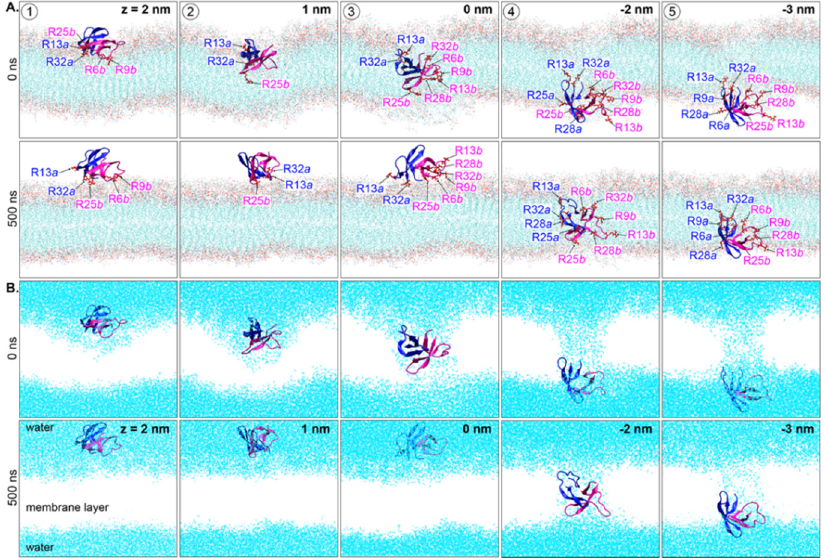
Figure 2. ( A ) Starting and final orientations of dimeric HD5 in a membrane at five positions. Water molecules in each system are shown in cyan in ( B ). Chains a and b of HD5 dimer are displayed in blue and pink. Key arginine (R) residues that are in contact with the membrane are also labeled.